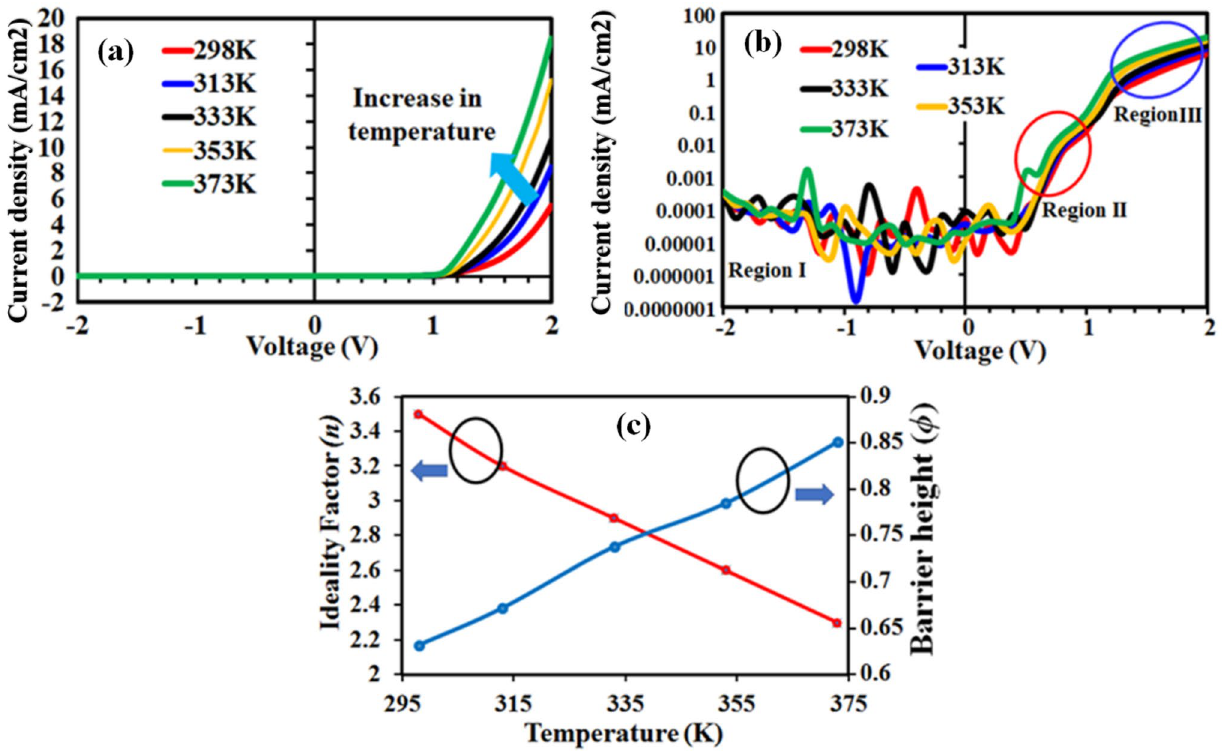
the Au/γ-CuI/β-Ga O /In heterojunction device for the temperature 2 3 range 298–373 K; c Variation in the ideality factor ( n ) and barrier height ( φ ) with an applied temperature in the range 298–373